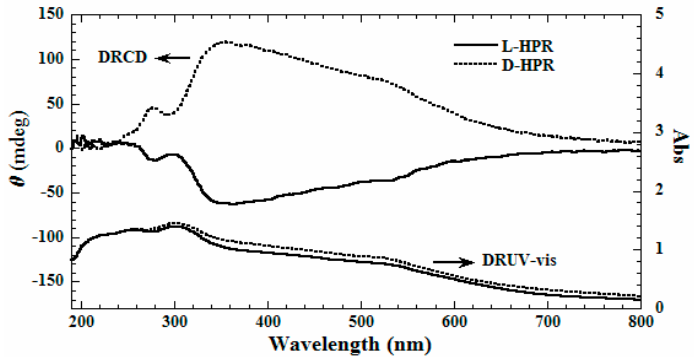
Figure 3. DRUV-vis and DRCD spectra of left-handed and right-handed helical phenolic resin bundles.